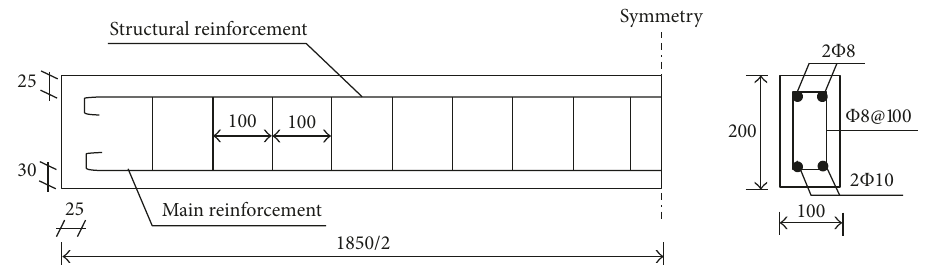
Figure 1: Steel bars used in an RC